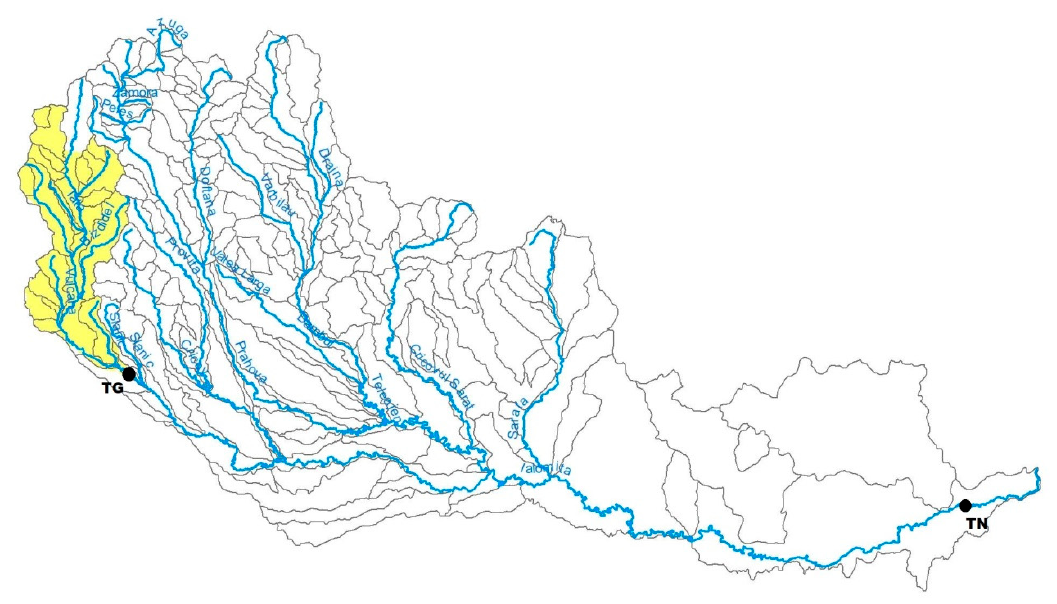
Figure 2. Monitoring points of water quality (dots) and the yellow area for soil and water assessment tool (SWAT) modeling considered for this study (other areas represent the composing sub-basins of Ialomita River Basin).